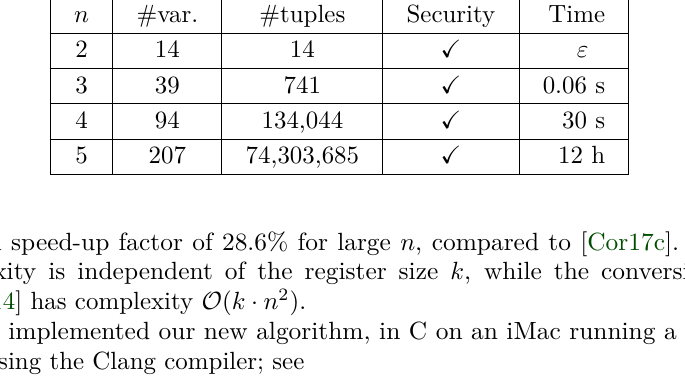
Table 5: Formal verification of the t -SNI property of the Boolean to arithmetic conversion algorithm from Section 4.1, for t = n − 1. n #var. #tuples Security Time